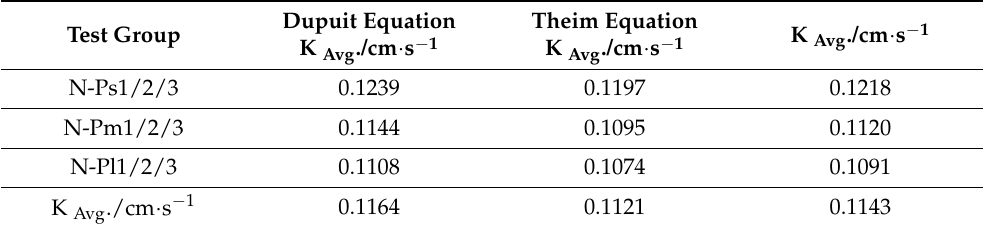
Table 2. Calculated results of pumping tests to determine permeability coefficients under the no well-skin model conditions.